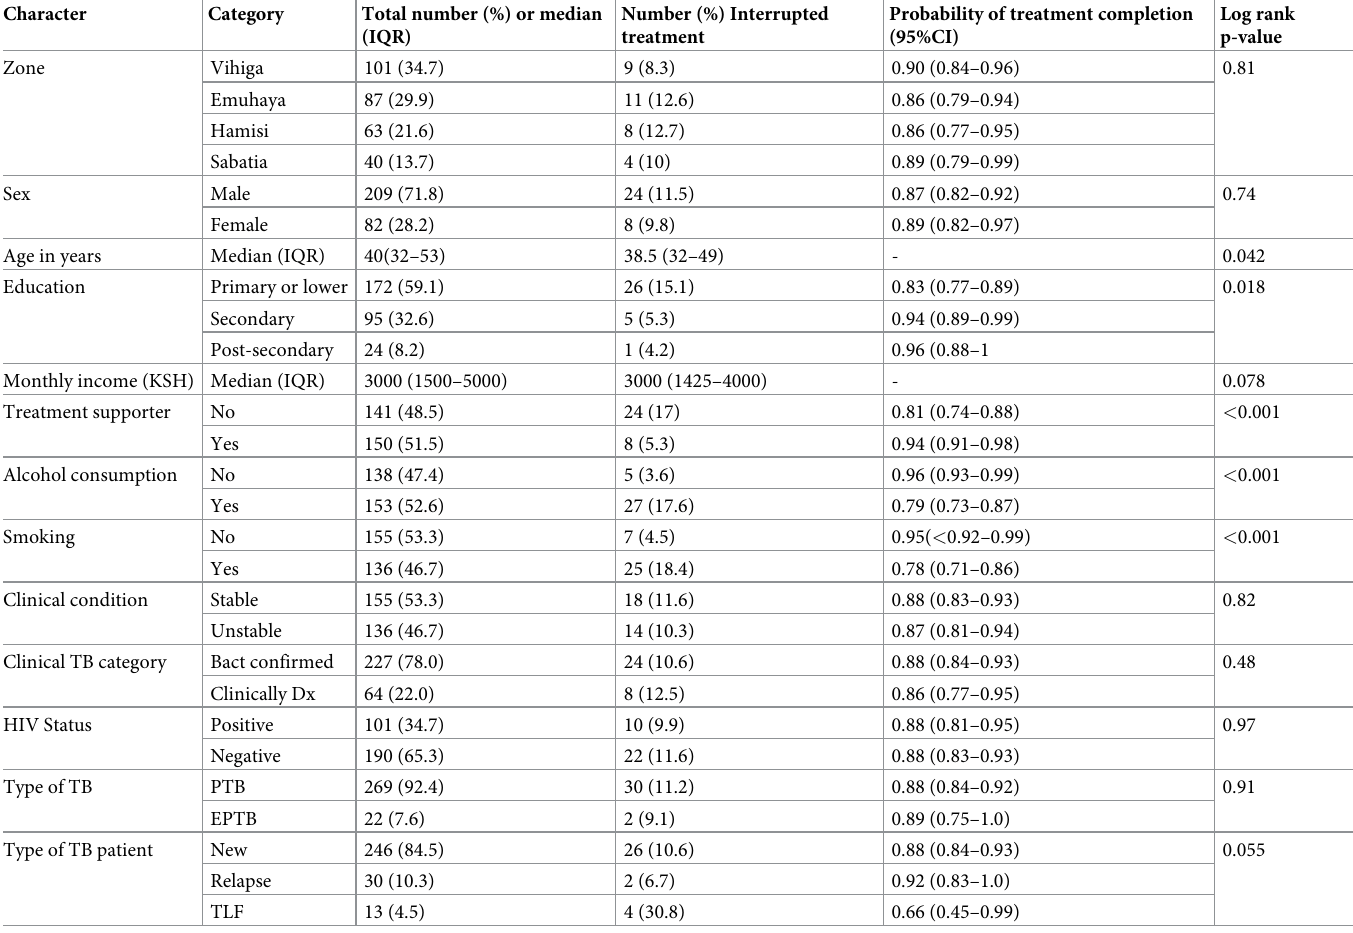
Table 2. Socio-demographic & clinical characteristics of TB patients by treatment interruption, probability of treatment completion and survival difference in Vihiga